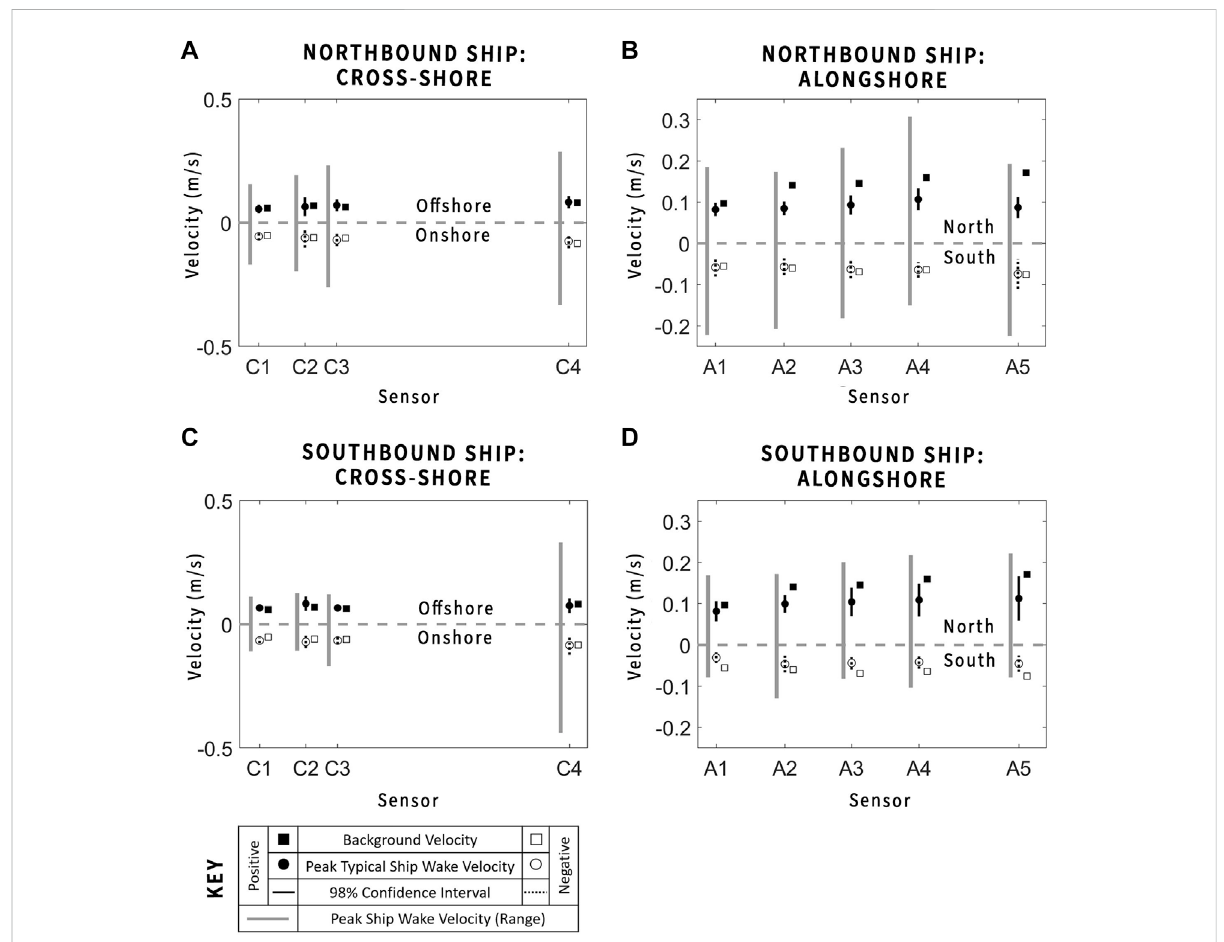
FIGURE 8 Peak(98thpercentile) velocitiesinthecross-shore (A,C) andalongshore (B,D) directionsfornorthbound (A,B) andsouthbound (C,D) shipwake events. Solid black lines/markers denote positive (offshore or north-directed) velocities and dotted lines/open markers denote negative (onshore or south-directed) velocities. Gray lines denote the ranges for ship wakes, black lines denote 98th percent con fi dence interval, circles are the ensemble-average for ship wakes, and squares are background